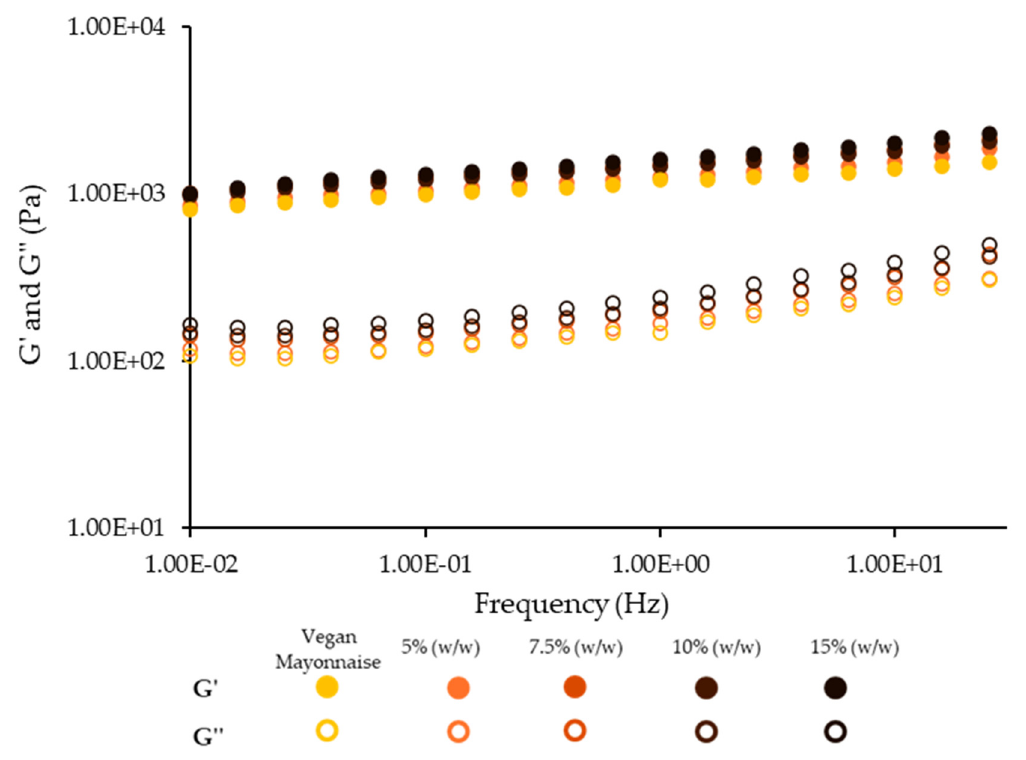
Figure 5. Mechanical spectra of emulsions with 5, 7.5, 10 and 15% ( w / w ) of miso paste and standard emulsion. G ′ corresponds to the elastic modulus and G ″ corresponds to the viscous modulus.